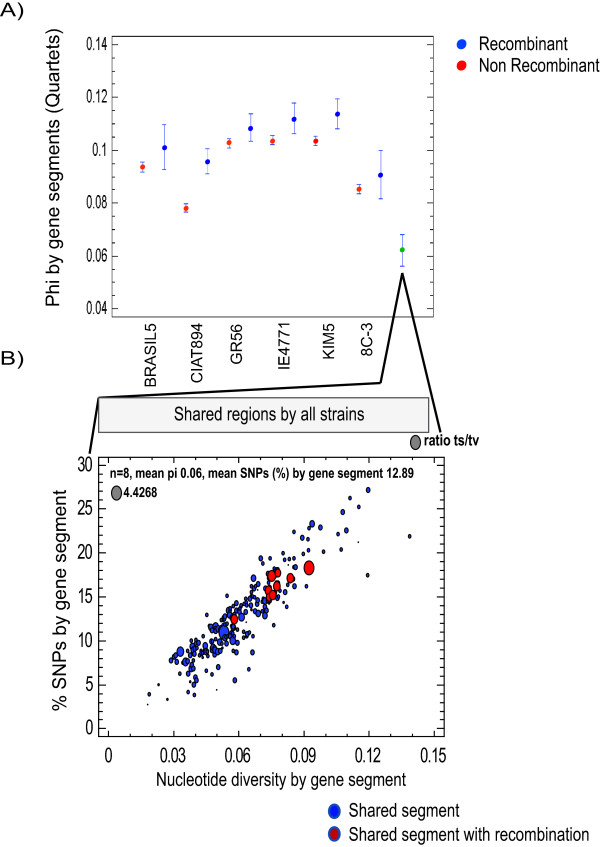
Genetic diversity in recombinant segments. A) For each homologous segment (quartet; regardless of evidence of recombination), we calculated the nucleotide diversity phi (Y axis; see Methods). The dots indicate the distribution means and the bars represent the 95% confidence intervals. Blue and red dots indicate recombinant and non-recombinant segments, respectively. Moreover, we determined the nucleotide diversity of the sequence regions shared across all of the tested strains of R. etli (green dot). Abscissa: BRASIL5, CIAT894, GR56, IE4771, KIM5, 8C-3 and shared regions. B) Magnification of the results from the 240 common sequence segments shared by all tested strains. The average percentage of SNPs was 12.89% per segment. The sphere sizes indicate the proportions of ts/tv for both recombinant segments (red circles) and non-recombinant segments (blue circles). The Y axis denotes the SNP percentage by gene segment, while the X axis shows the nucleotide diversity.